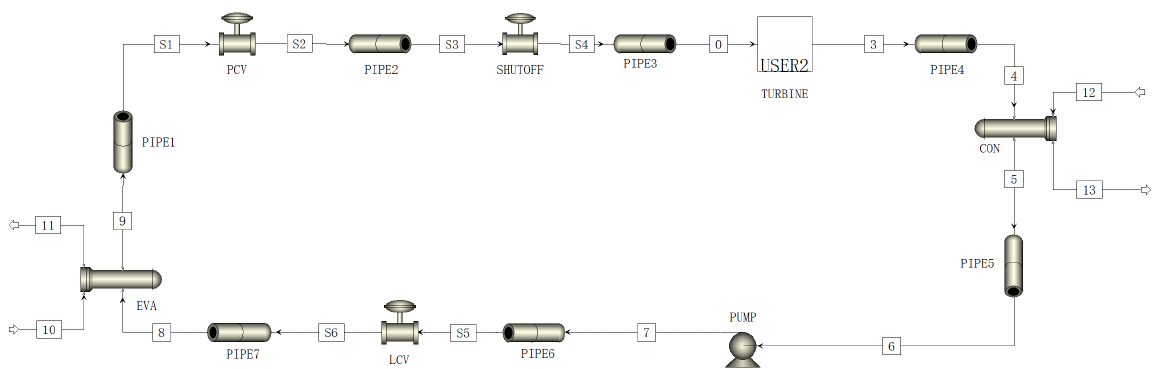
Figure 2. The Aspen Plus model. PCV: the pressure control valve; PIPE1~PIPE7: the pipe segment; SHUTOFF: the shut off valve; CON: the condenser; PUMP: the working fluid (R134a) pump; LCV: the control valve used for controlling liquid level in evaporator; EVA: the evaporator; 1~13 and S1~S6: the symbol mark of the inlet and outlet of each components.